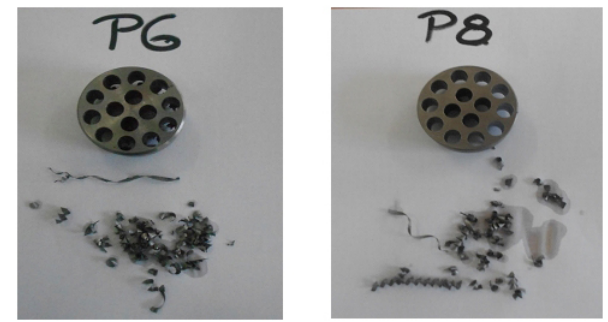
Figure 26. Chip shapes for different